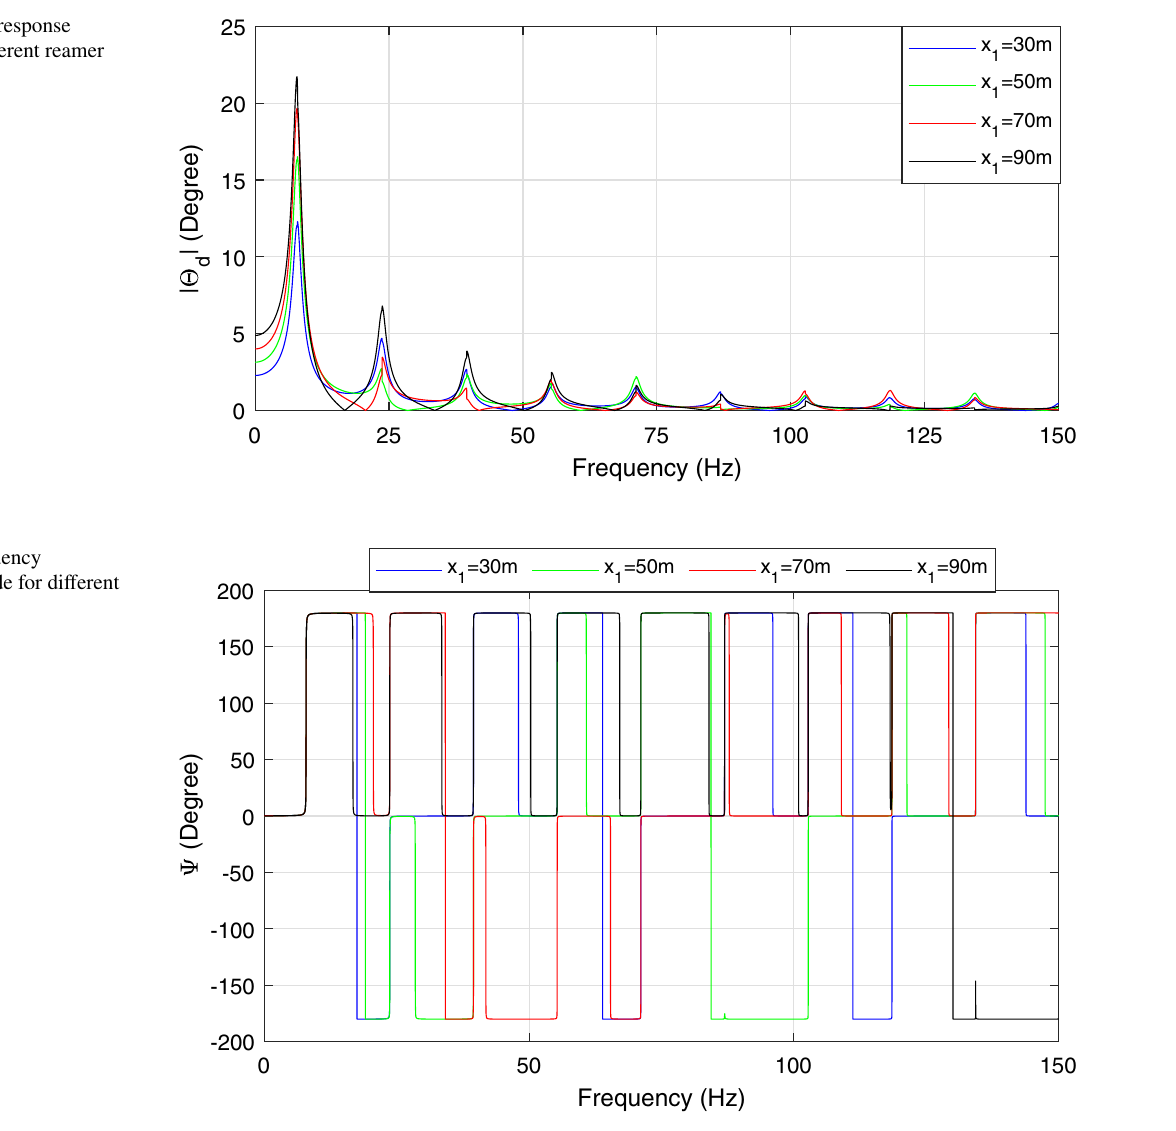
Fig. 7 Frequency response magnitude for different reamer locations